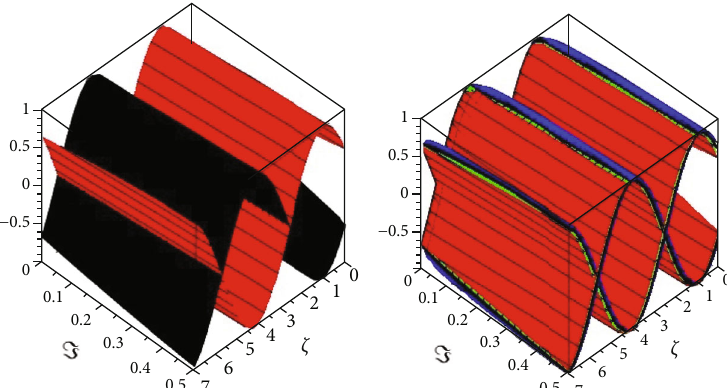
Figure 1: The fi rst graph shows the approximate solution of fuzzy upper and lower portions, and the second fi gure is the various fractional order of ℘ .